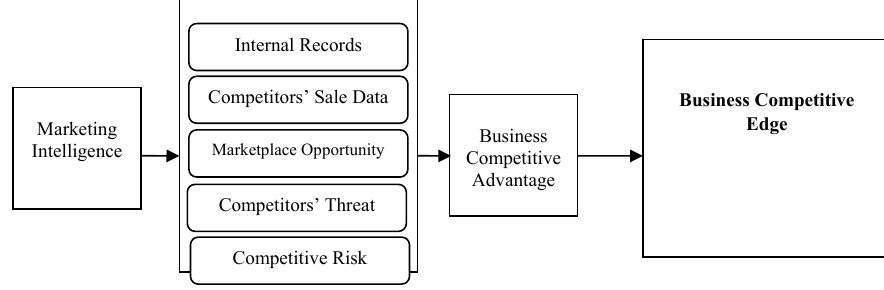
Fig. 1 - Model of Marketing Intelligence and Business Competitive Edge. Source: Conceptualized by the Researcher,